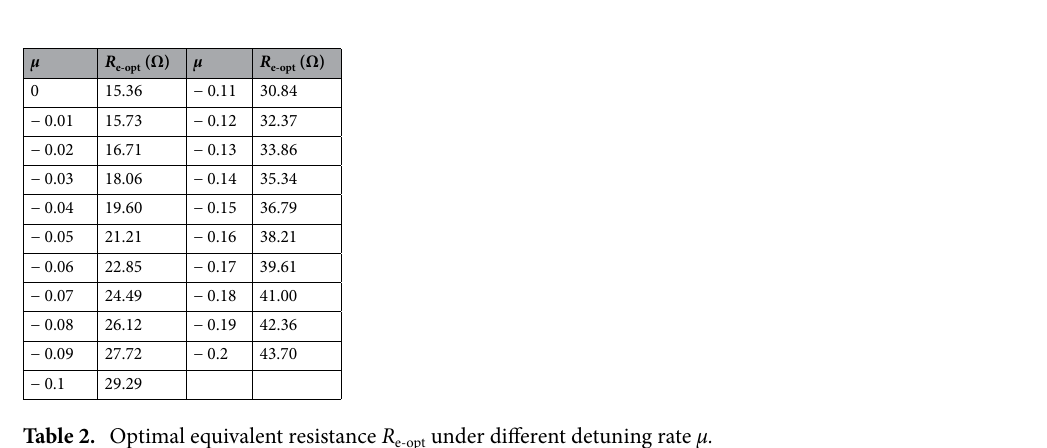
Table 2. Optimal equivalent resistance R e-opt under different detuning rate